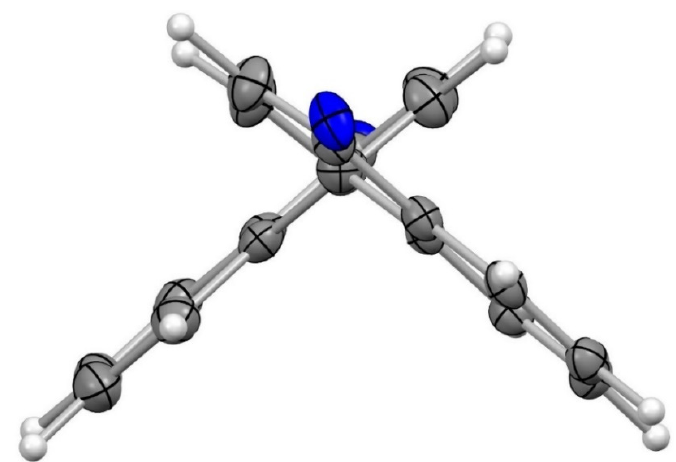
Figure 4. Crystal structure of compound 4 with a view along the N21–C4/C1–C11/C14–N34 axis (ORTEP plot showing thermal ellipsoids at the 50% probability level, the N –phenyl substituents have been omitted for clarity). Torsional angle (C2–C1–C11–C12) 99.4(2)°.